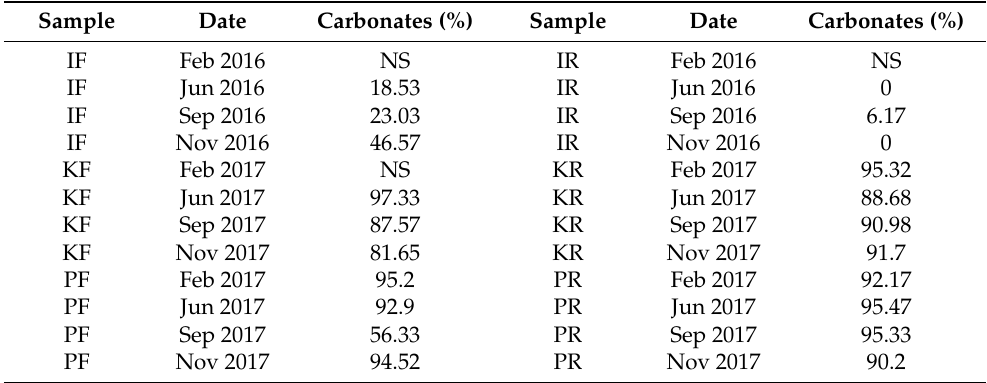
Table 4. Summarized carbonate content in sediment samples from all studied locations and